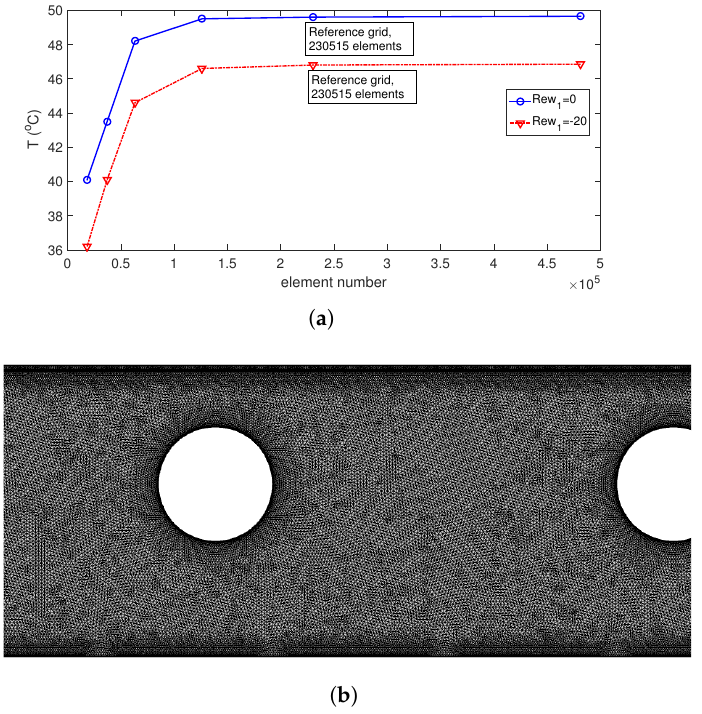
Figure 2. GIT results for average PST at two different rotational speeds of the first cylinder ( a ) and mesh distribution near the RCCs and panel ( b